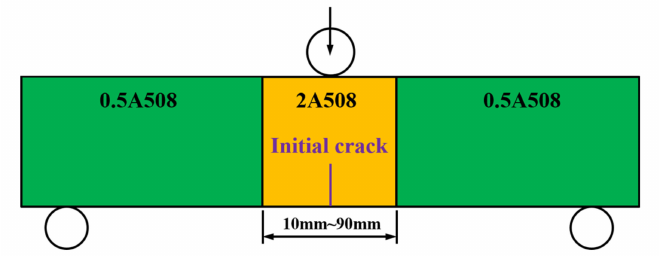
Figure 4. The structure and materials of the third crack-branching